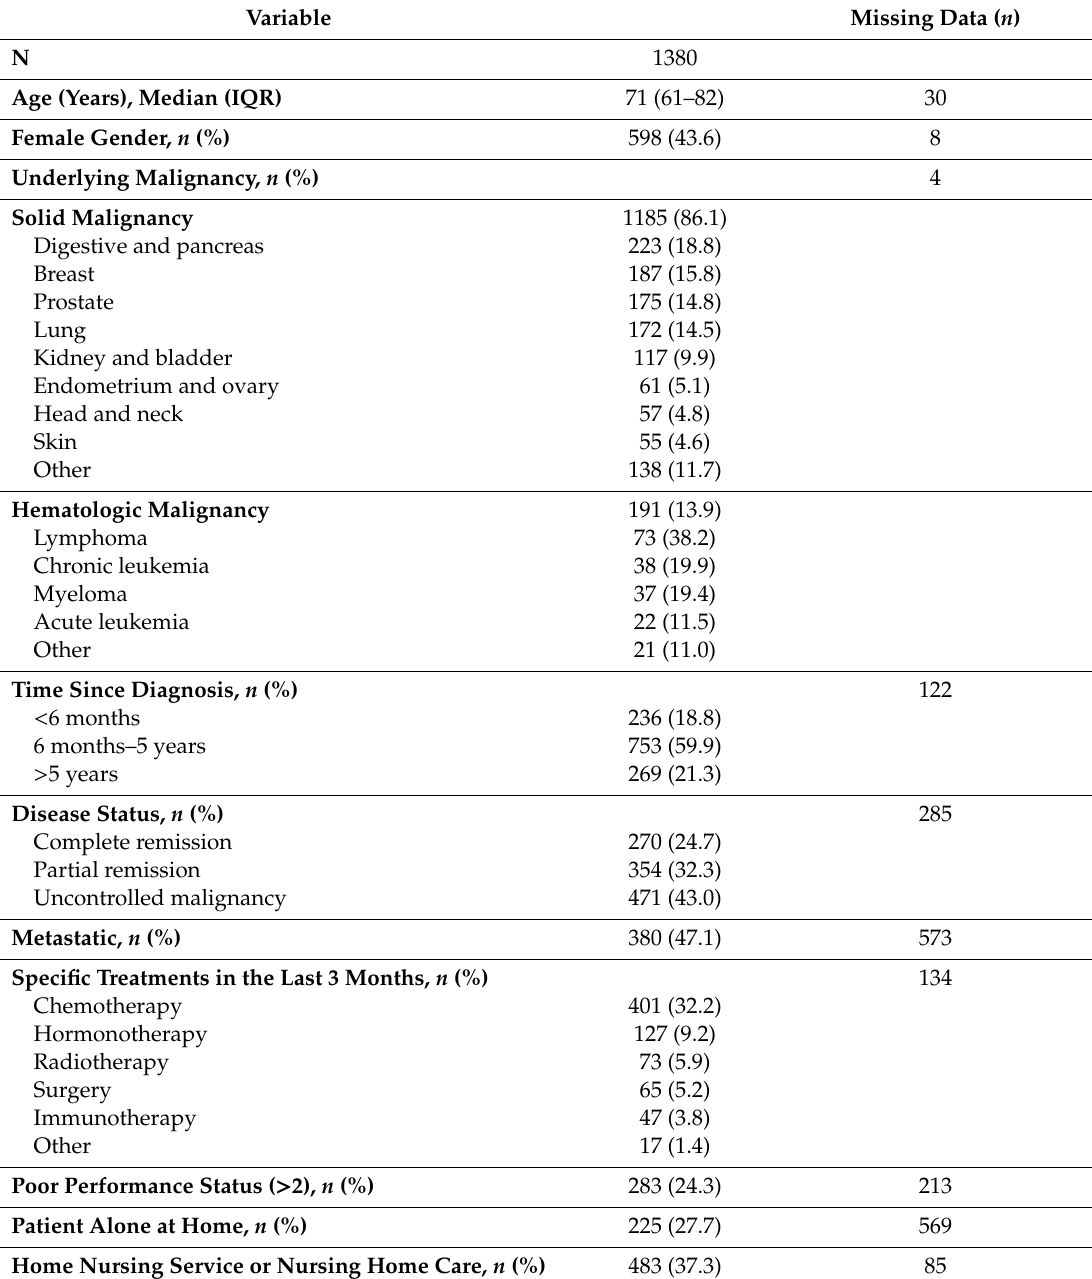
Table 2. Patient